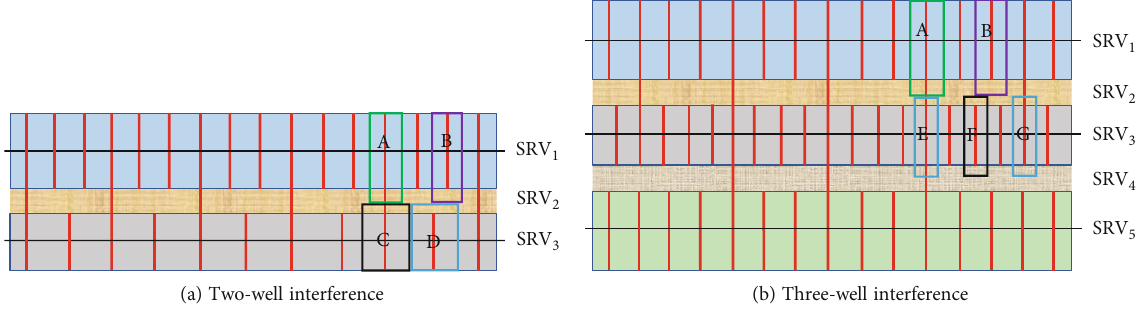
Figure 1: Schematic of a well pad with fracture connection between the parent and in fi ll wells.